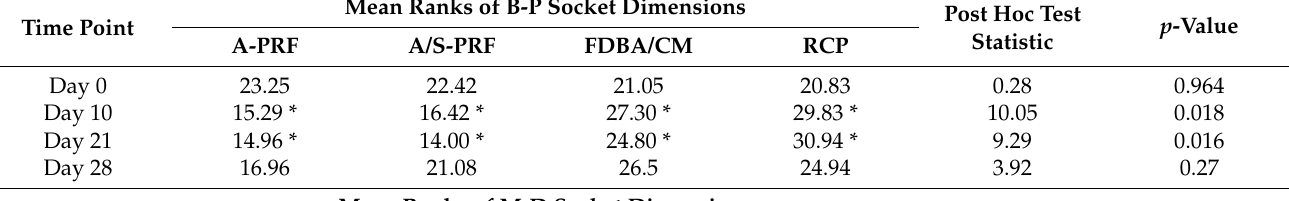
Table 2. Comparison of mean ranks of B-P and M-D socket dimensions on day 0, day 10, day 21, and day 28 among the 4 study